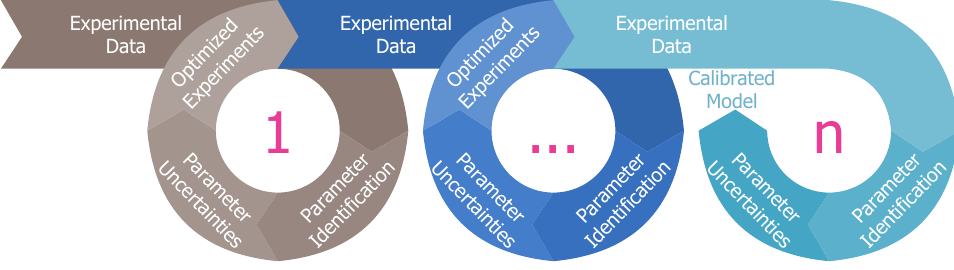
Figure 1. Standard workflow of identifying model parameters in process modeling with n